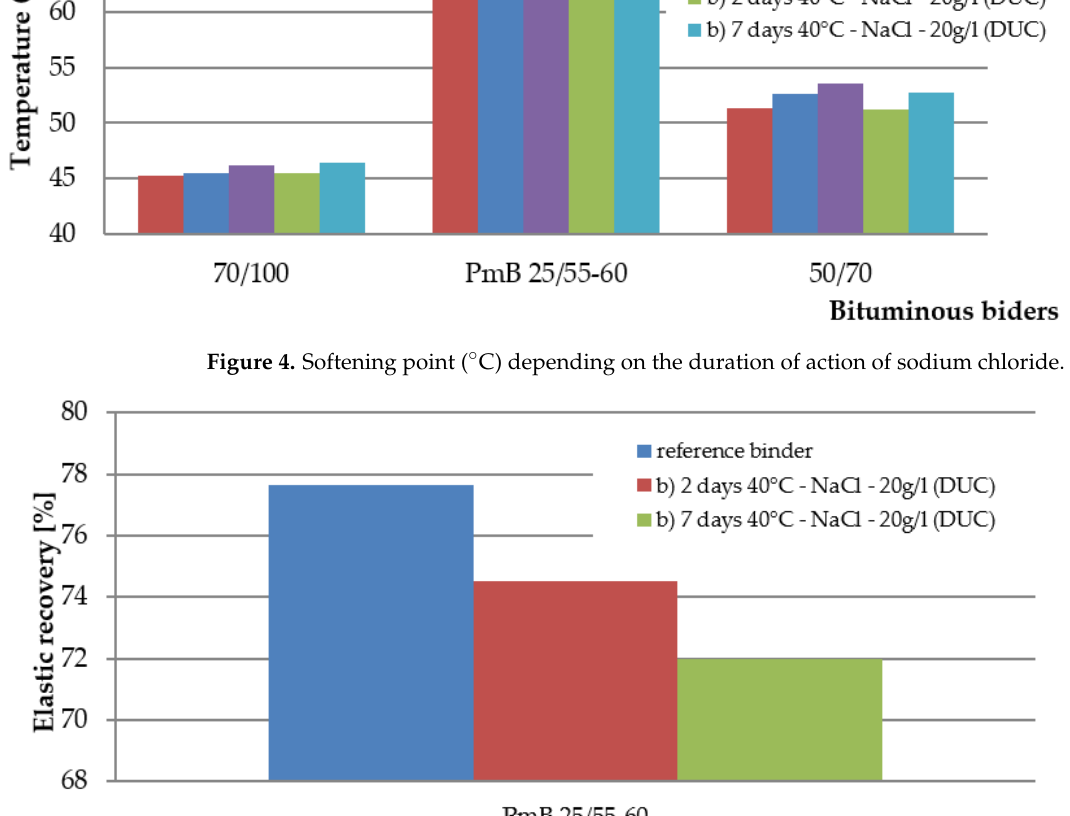
Figure 6. Change in the shape of the asphalt binder test samples (Photo: Authors). 3.2. Strength and Deformation Characteristics of Asphalt Mixtures Marshall samples were into four groups divided: air (reference: 0 freeze – thaw cy- cles), 25 freeze – thaw cycles, 50 freeze – thaw cycles, and 75 freeze – thaw cycles. All four groups had approximately the same bulk specific gravity (Figure 7). Air void value was 2.0% for the “Air” and “75 freeze – thaw cycles” groups of samples and the value of 2.2% for the “25 and 50 freeze – thaw cycles” groups of samples. The increasing number of freeze – thaw cycles increases the absorption value from 1.5% to 3.4% (Figure 8 ): “Air” group samples — values of 1.1 – 1 .9%; “25 freeze – thaw cycles”— values of 2.3 – 2 .4%, “50 freeze – thaw cycles”— values of 2.8 – 3.3%; and “75 freeze – thaw cycles”— values of 2.9 –